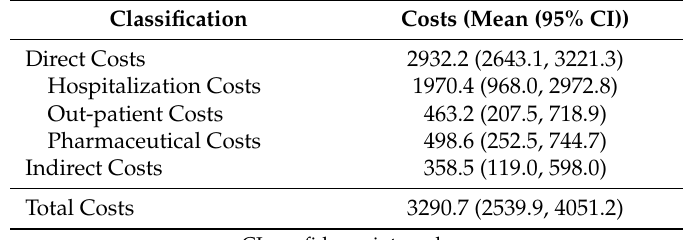
CI: confidence interval.